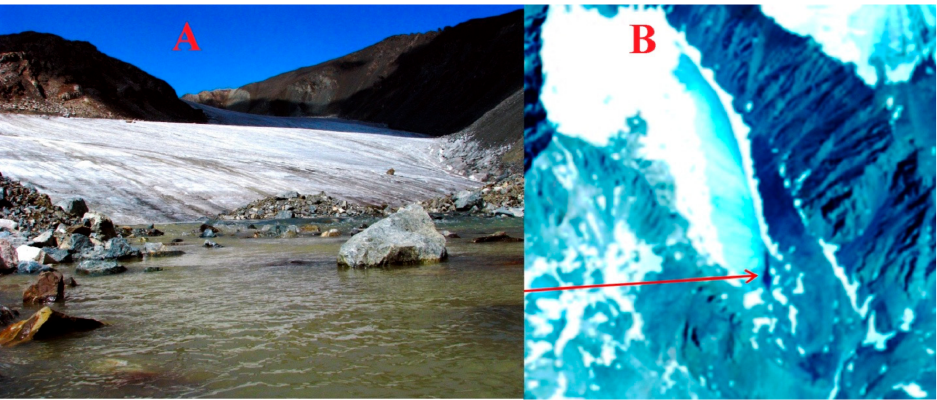
Figure 6. ( A ) A proglacial lake at the Tolaiti Glacier terminus, Mongun-Taiga, photo by authors, 2008; ( B ) the same place, satellite image, SPOT 5 21 July